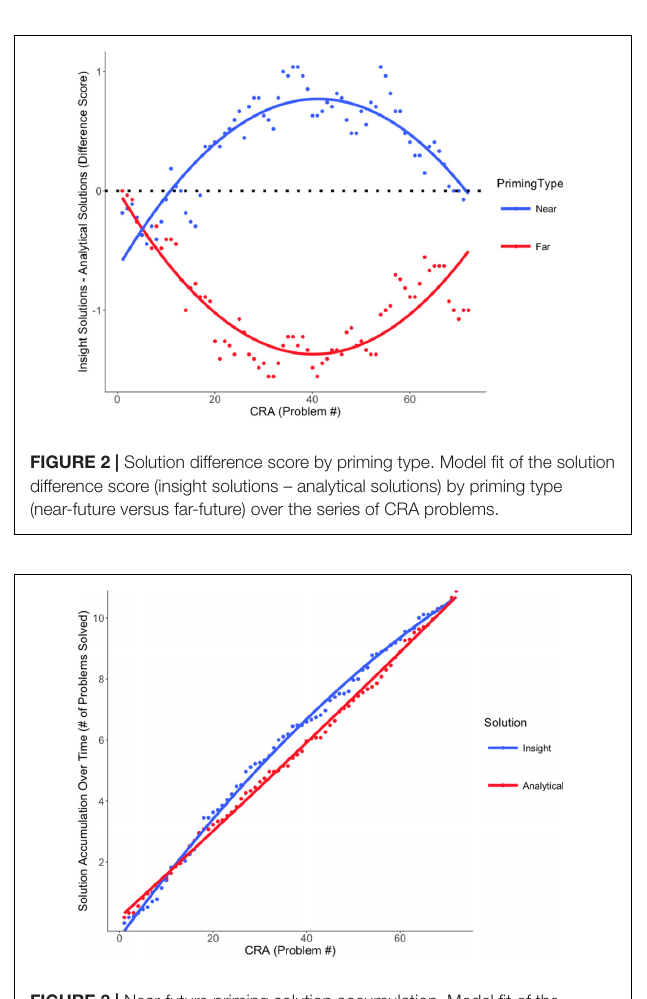
FIGURE 3 | Near-future priming solution accumulation. Model fit of the accumulated solutions (insight versus analytical) over the series of CRA problems in the near-future priming condition. Although participants used roughly the same number of each solution type, insightful solutions initially accumulated somewhat more rapidly than analytical solutions.